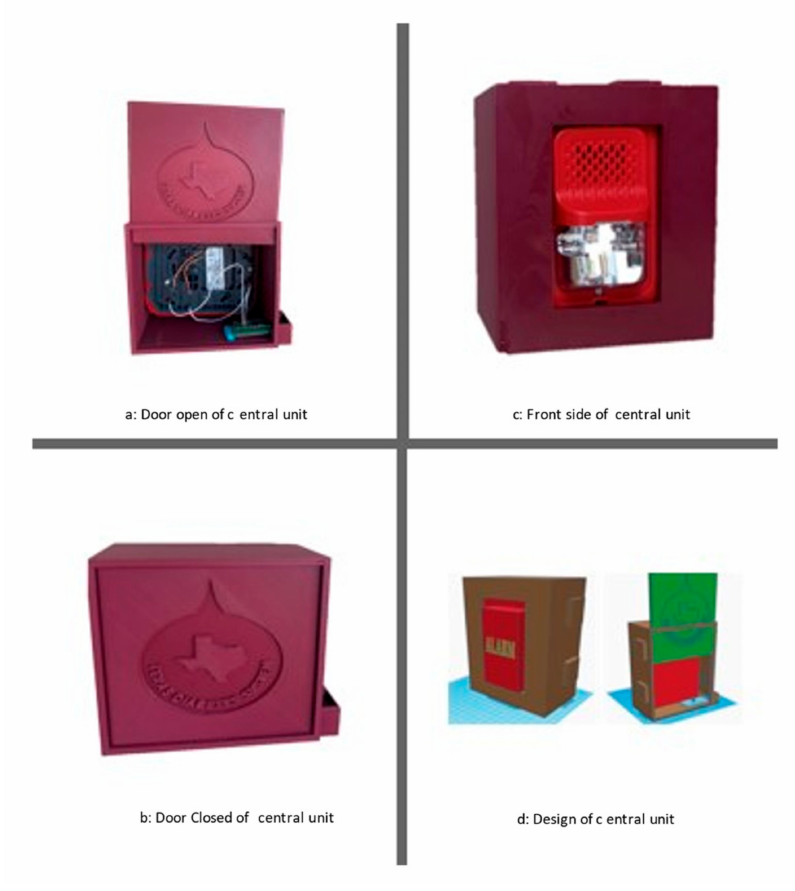
Figure 9. DiAtack Central Unit.